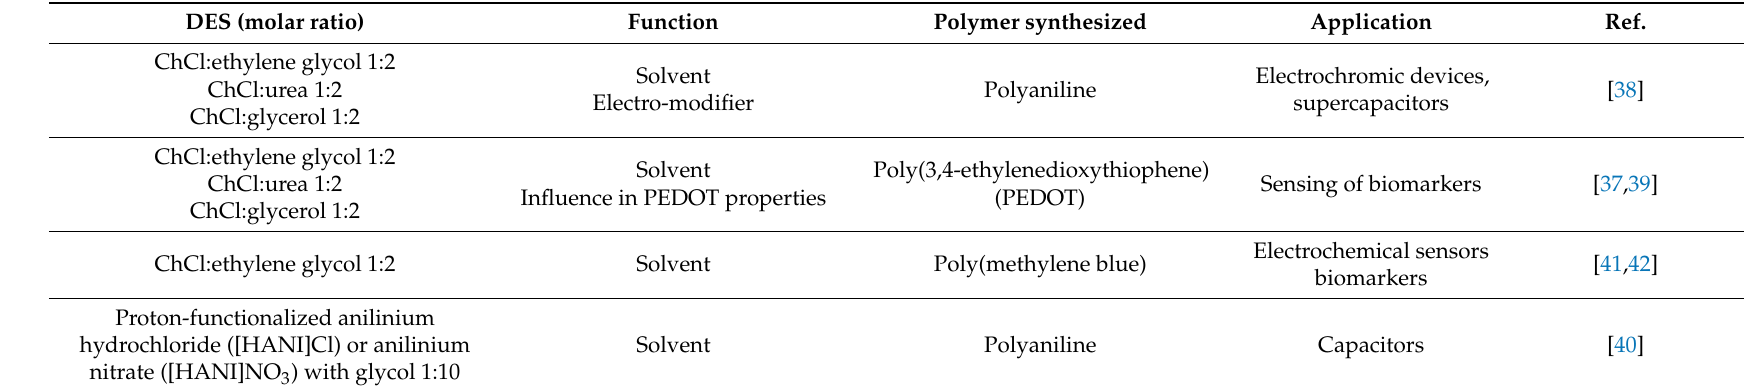
Table 1. Summary of DES and their function in electropolymerization, polymers produced, and their potential applications. DES (molar